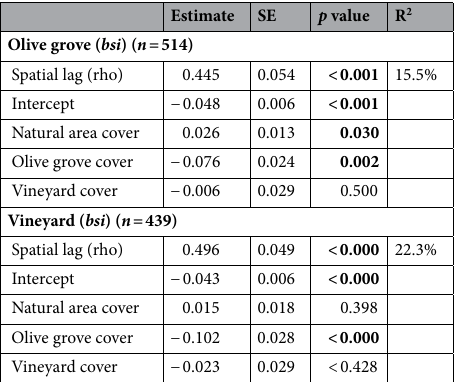
Table 1. Results of the spatial autoregressive model (SAR) relating the proportion of the three land-cover types on the Biocontrol Service Index ( bsi ) estimated for all those 10 × 10 grid cells in which olive groves and vineyards were present. Significant p values ( p < 0.01) are highlighted in bold.